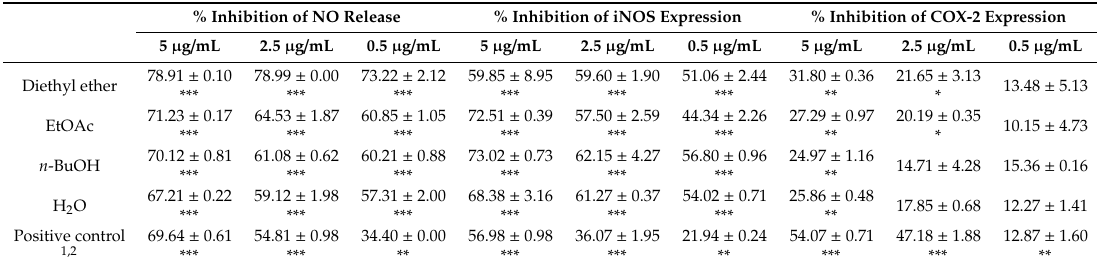
Table 3. E ff ect of tested of the subfractions of D. diapensifolia . on NO release, iNOS and COX-2 expression. Data are expressed mean ± S.E.M of the percentage of inhibition vs. LPS (n = 3). ***, **, * denote p < 0.001, p < 0.01, p < 0.05 vs. LPS. % Inhibition of NO Release % Inhibition of iNOS Expression % Inhibition of COX-2 Expression 5 µ g / mL